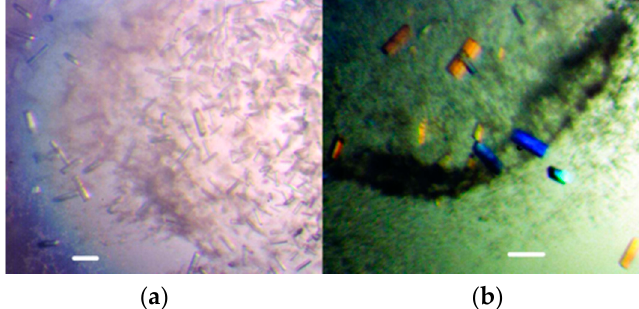
Figure 2. Crystals of an N-terminal fragment of rat liver ribosomal P2 protein with and without an oil barrier. ( a ) Control ( b ) with oil barrier [18].